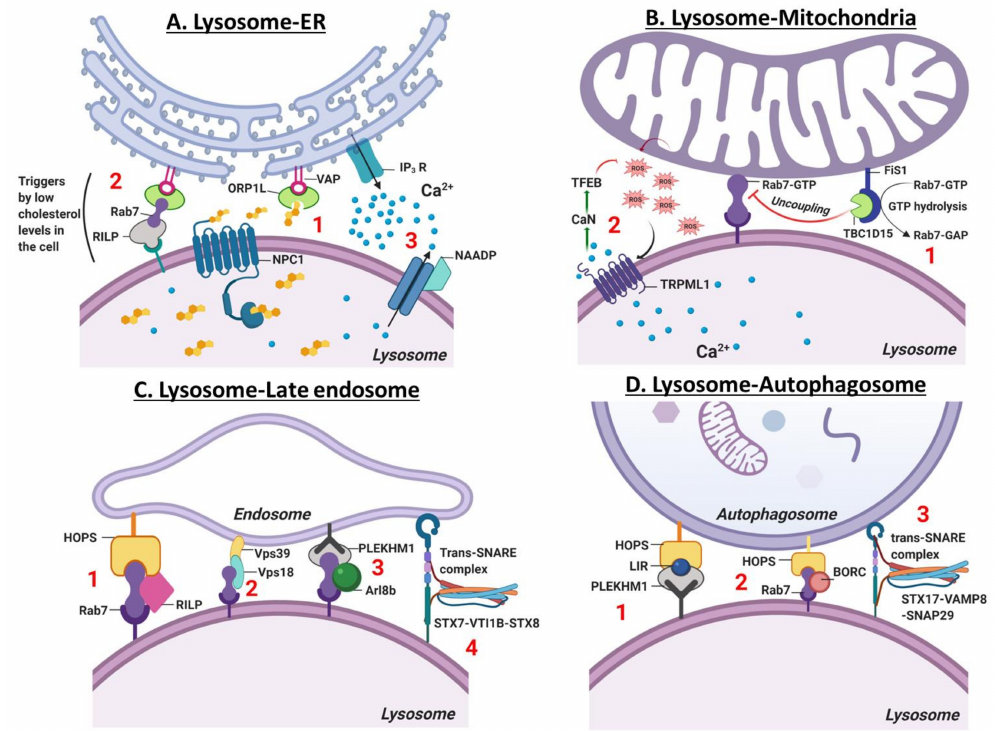
Figure 3. Organellar contact site and fusion with lysosome. ( A ). Lysosome-ER: Lysosome-ER contact site regulates ER Ca 2 + release. (1) Lysosome-ER contact site shuttles free cholesterol from the lysosome to ER via concerted action of lysosomal membrane-localized protein, NPC1 and ER membrane proteins, VAPA (vesicle-associated membrane protein (VAMP)-associated ER protein A) and VAPB and a lipid-transfer protein, ORP1L (oxysterol-binding protein-related protein 1L). (2) Low cellular cholesterol level activates ORP1L, which then triggers the formation of a contact site between ER and lysosomal membrane. ER-resident protein VAP anchors with lysosomal Rab7-RILP (Rab7-interacting protein) to initiate the movement of lysosomes to plus-end or towards the cell periphery. (3) NAADP (nicotinic acid adenine dinucleotide phosphate), a Ca 2 + mobilizing entity and IP3 receptor agonist mobilizes lysosomal Ca 2 + and facilitates ER Ca 2 + release into the cytosol. ( B ). Lysosome-Mitochondria: Lysosome-mitochondria contract site mediates the bidirectional regulation of lysosome and mitochondria dynamics. (1) Mitochondria forms a contact with the lysosome via lysosomal bound Rab7-GTP. This contact site is disrupted by mitochondrial fission 1 membrane protein, FIS1andrecruitsTBC1D15(TBC1DomainFamilyMember15)whichhydrolyzesRab7-GTPtoRab7-GAP. (2) Lysosomal mucolipin channel, TRPML1 (Transient Receptor Potential Cation Channel, Mucolipin subfamily) governs mitochondria homeostasis by sensing and scavenging mitochondrial ROS (reactive oxygen species). TRPML1 is activated by ROS that induces Ca 2 + release from the lysosomal lumen and activates nuclear TFEB translocation in a calcineurin-dependent manner. TFEB induces lysosome biogenesis and autophagy to clear damaged mitochondria and scavenge ROS. ( C ). Lysosome-Late endosome: The fusion of lysosome and late endosome occurs via tethering processes, which involves; (1) coupling of small GTPase Rab7, Rab7-interacting protein (RIPL) and vacuole protein sorting (HOPS) complex, (2) interaction of Rab7, VPS18 and VPS39 (3) Rab7, Arf-like (Ar18b) and Rab7 e ff ector PLEKHM1 (pleckstrin homology domain-containing protein family member 1 and (4) formation of Trans-SNARE assembly composed of syntaxin-7 (STX7, Qa-SNARE), VTI1B (VPS10 tail interactor-1B, Qb-SNARE) and syntaxin-8 (STX8, Qc-SNARE). ( D ). Lysosome-autophagosome: The fusion of lysosome and autophagosome occurs via (1) HOPS complex and Rab7 e ff ector protein, PLEKHM1 which binds to HOP via LC3-interacting region (LIR) (2) BLOC-1 related complex (BORC1) that recruits Rab7 and HOPS for tethering and (3) enabling trans-SNARE complex formation of STX17-VAMP8-SNAP29 to induce autophagosome-lysosome